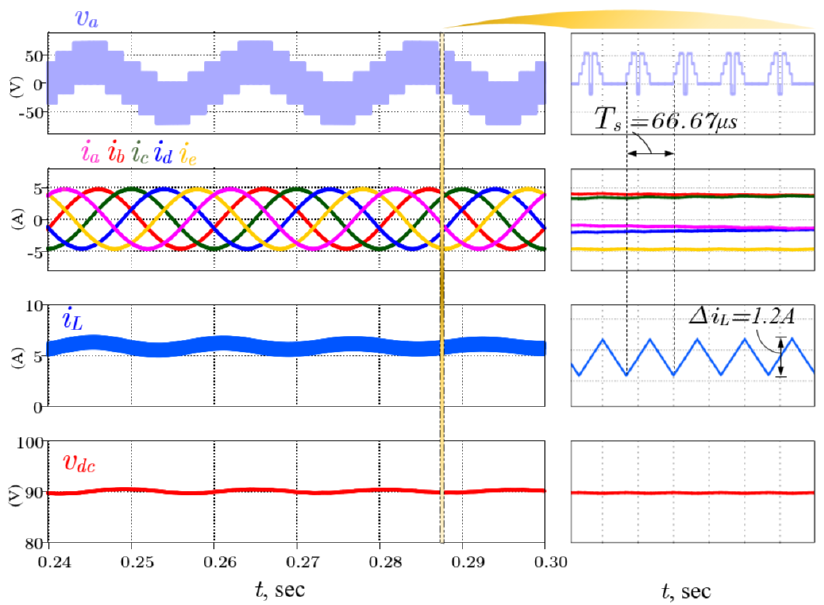
Figure 17. Simulated voltages and current waveforms of the five-phase SSI under the case study using PLECS.